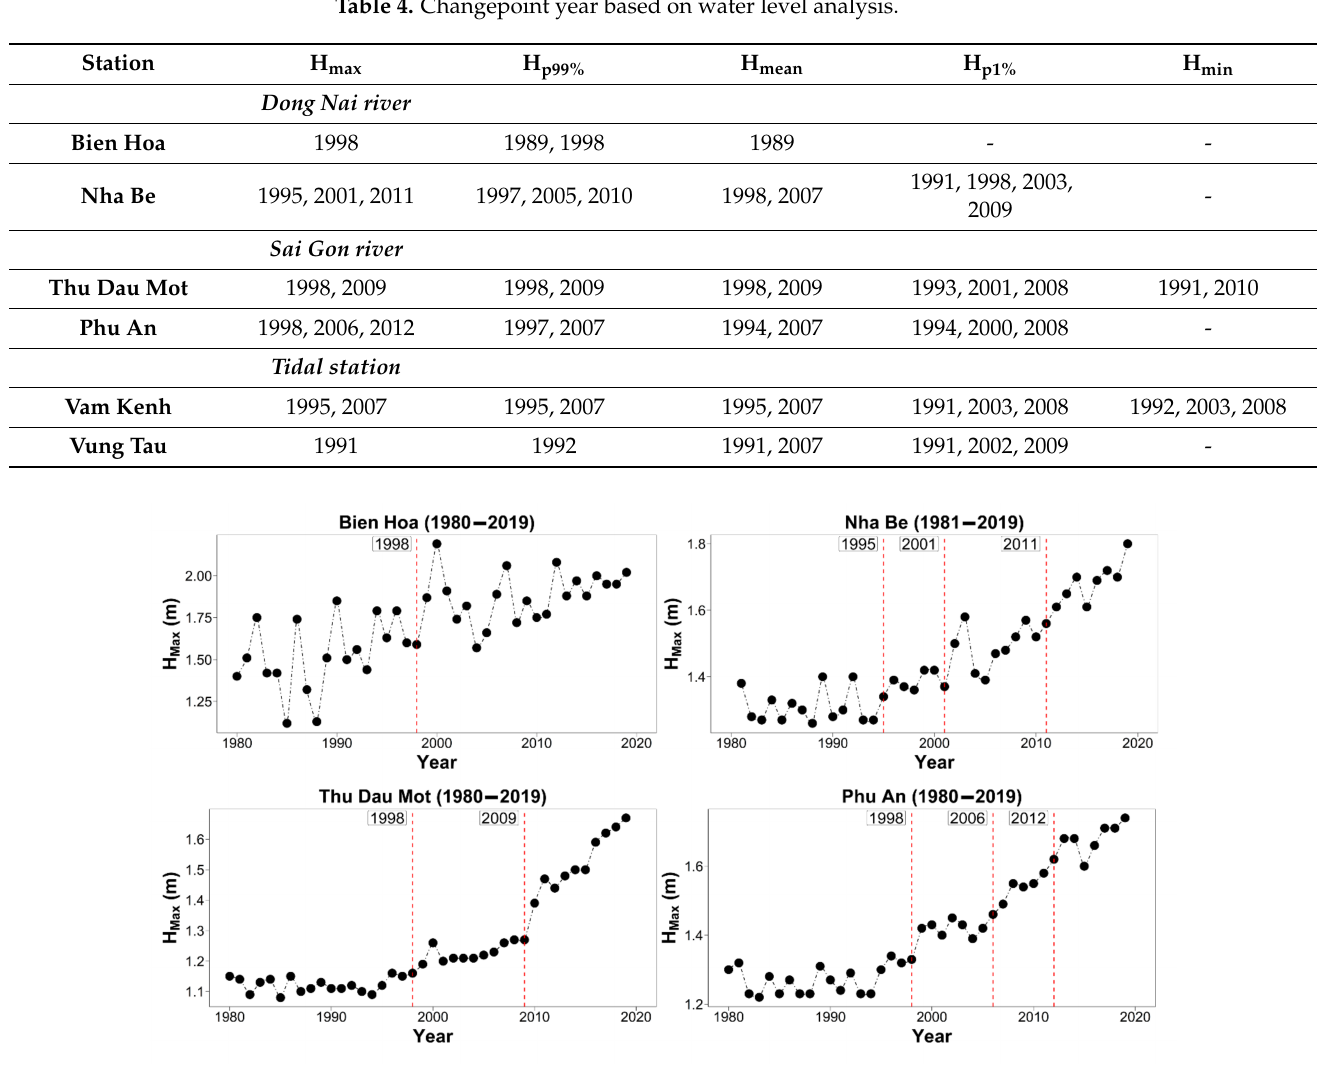
Table 4. Changepoint year based on water level analysis.